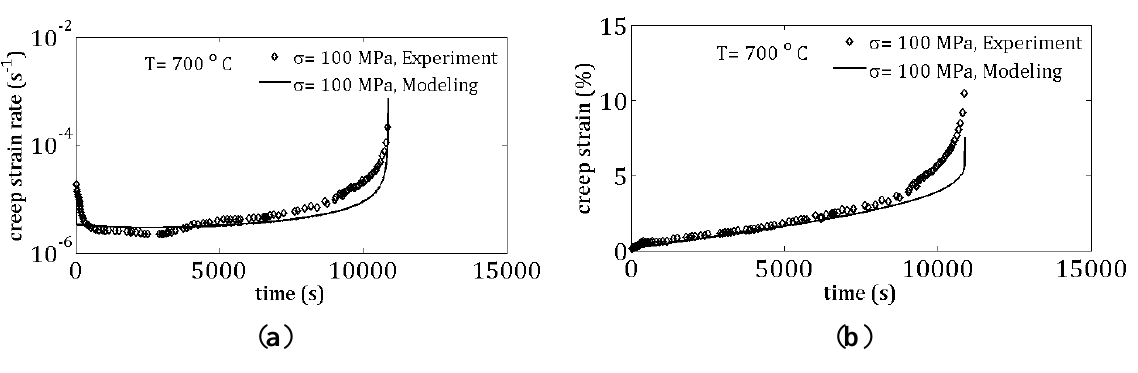
Figure 12. Creep results from experiments and finite element simulation for 200 MPa and 650 °C: ( a ) creep strain rate versus time; and ( b ) true creep strain versus time. Figure 13a,b show the comparison of creep strain rate versus time and true creep strain versus time at 700 °C and applied stress of 100 MPa.